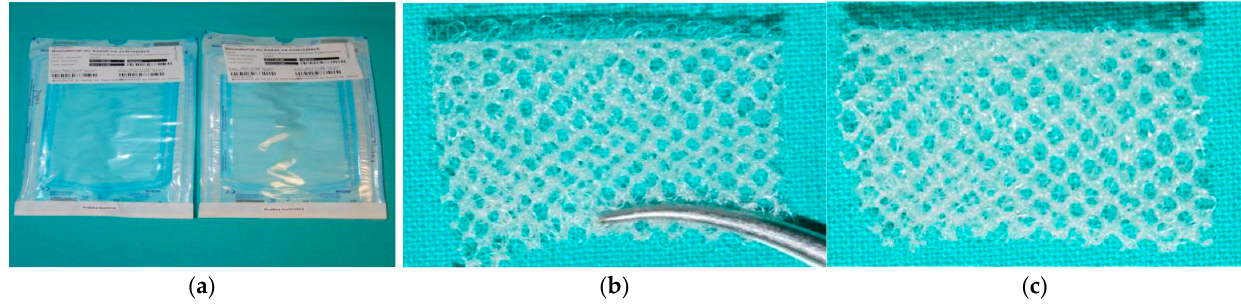
Figure 2. The knitted implants used to estimate the local effect after implantation: ( a ) materials for the test used; ( b ) macroscopic view of the surface with loops; ( c ) macroscopic view of the opposite surface without loops and PACVD-modified with the presence of the fluoropolymer.